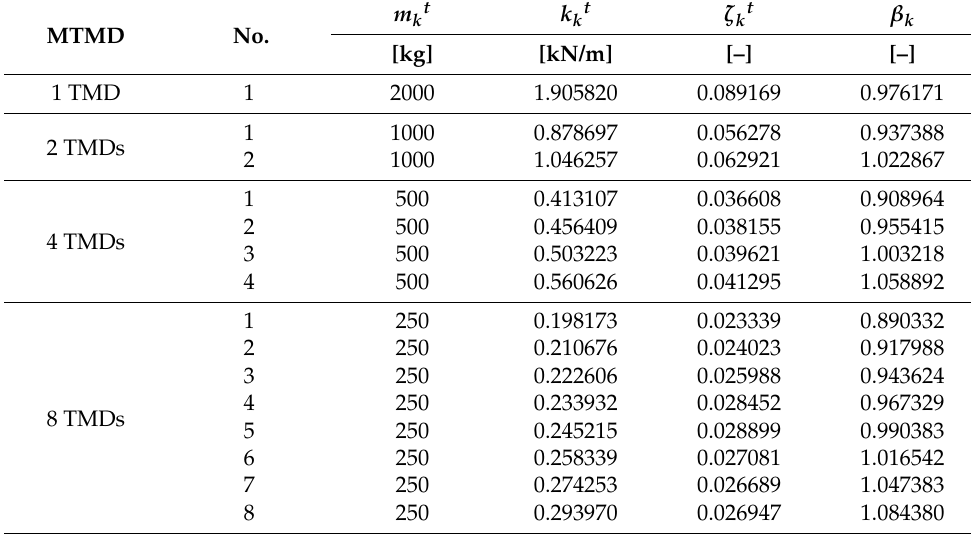
Table 4. Optimal k kt , ζ kt , β k values obtained for the J 2 objective